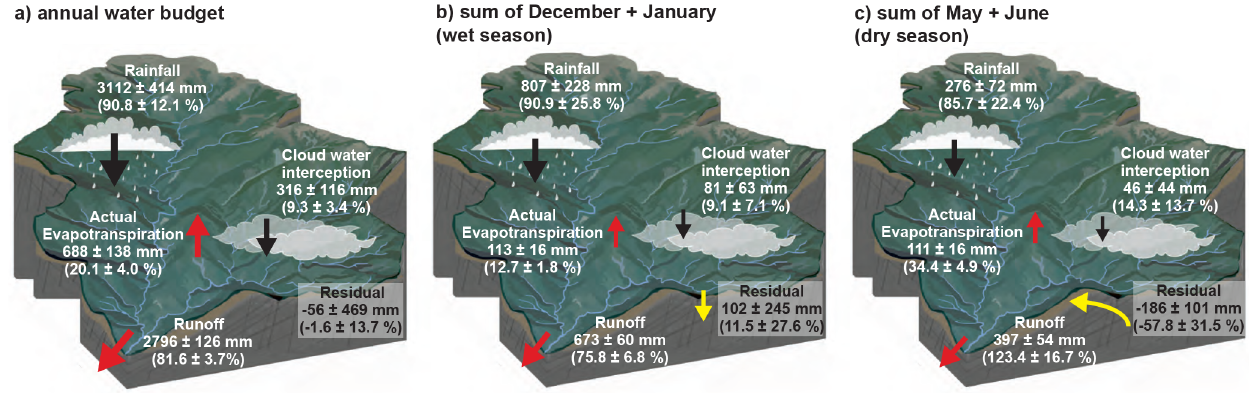
Figure 8. A schematic illustration of the water budget for the Kosñipata catchment for (a) the study year, (b) the early wet season (December and January), and (c) the early dry season (May and June). Black arrows represent inputs, and red arrows represent outputs; yellow arrows represent the reversible flux of the residual over the wet and dry seasons, reflecting the transient seasonal storage of water in soil and fractured bedrock (see Discussion in text). The sizes of the arrows are scaled logarithmically with the magnitude of the flux. Values indicated are sums for that time period in